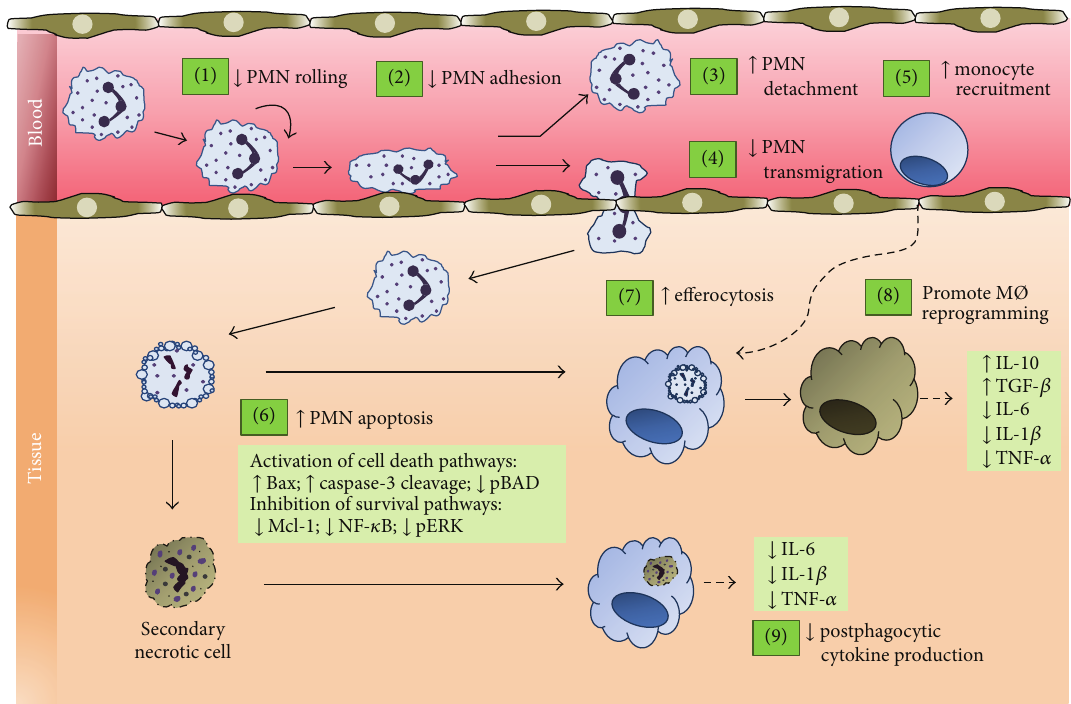
Figure 1: Cellular events associated with the anti-inflammatory and proresolving effects of annexin A1 (AnxA1) and its mimetic N- terminal peptides. AnxA1 modulates a wide range of cellular and molecular steps of the inflammatory response and is deeply involved in the endogenous mechanisms that are activated to bring about proper resolution. Pharmacological administration of AnxA1 results in decreased neutrophil rolling (1) and adhesion (2) to endothelium, increased detachment of adherent cells (3), and inhibition of neutrophil transmigration (4). In addition, AnxA1 is able to induce apoptosis, overriding the prosurvival signals that cause prolonged lifespan of neutrophils at the inflammatory site (6). Endogenous and exogenous AnxA1 also promote monocyte recruitment (5) and clearance of apoptoticneutrophilsbymacrophages(7).Phagocytosisofapoptoticneutrophilsbymacrophagesiscoupledwithreleaseofanti-inflammatory signals, including transforming growth factor- 𝛽 , and lower levels of proinflammatory cytokines (8). Besides, AnxA1 is related to macrophage reprogramming toward a proresolving phenotype (8). Initial in vitro studies using AnxA1 knock-down leucocytes demonstrate that AnxA1 prevents proinflammatory cytokine production after phagocytosis of secondary necrotic cells. This effect provides an important fail-safe mechanism counteracting inflammatory responses when the timely clearance of apoptotic cells has failed